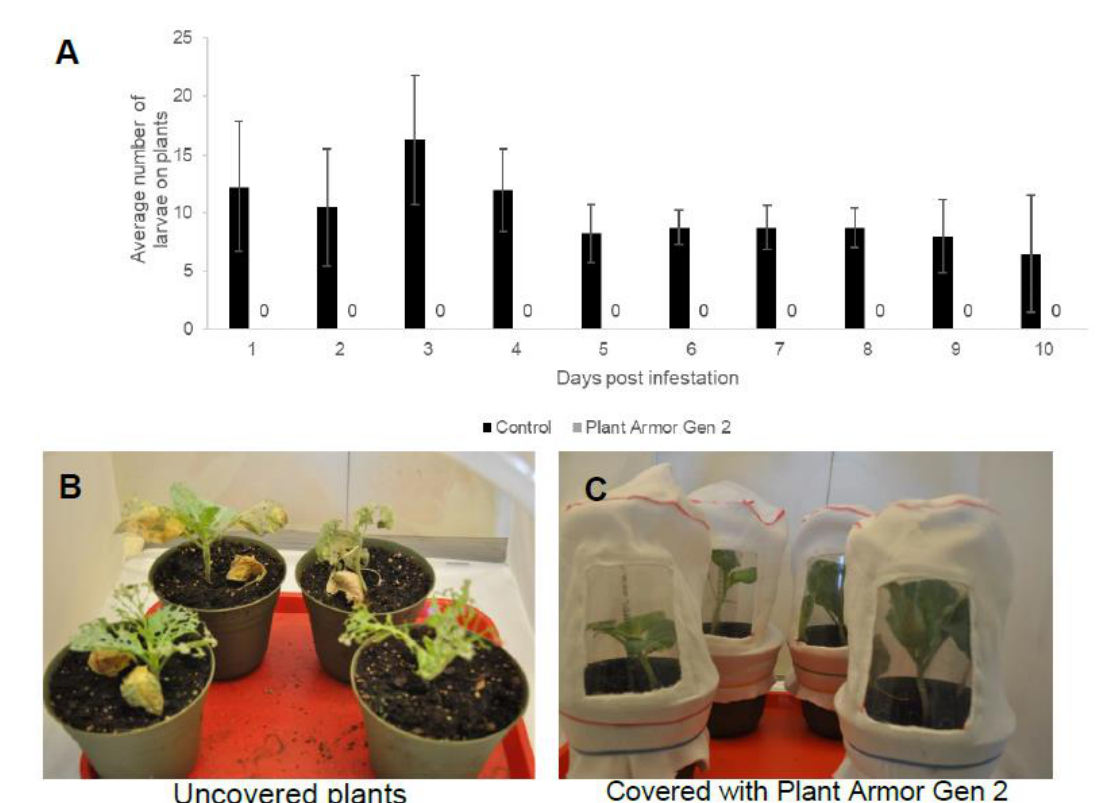
Figure 7. Whole plant penetration (WPP) bioassay with bollworm, Helicoverpa zea , neonate caterpillars. ( A ) Number of neonates that penetrated Plant Armor Generation (Gen) 1 versus number found on the uncovered plants at different days after the study was started (the zeros shown were for Plant Armor Gen 2 where no larvae were found on the plants). Condition of the plants 10 days after the start of the bioassay is presented for uncovered ( B ) and covered ( C ) plants. A window made of transparent plastic was glued to the Plant Armor as shown in ( C ) to monitor H. zea penetration. Error bars are ±1 SEM.